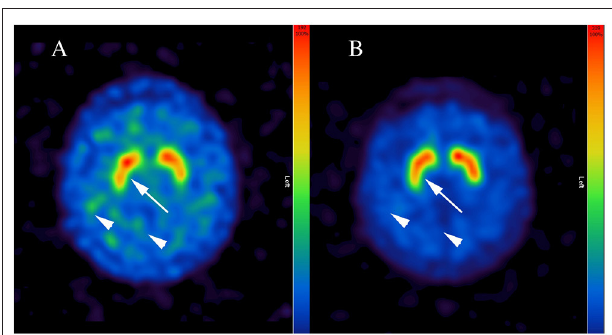
FIGURE 1 | Representative [ 123 I]FP-CIT-SPECT images of the patient. Note inhomogeneous and reduced dopamine transporter binding of the radiopharmaceutical in putamen bilaterally (arrow in A ) and low contrast between striatal and cortical binding during short-term bupropion therapy (arrowheads in A ), which normalized after a wash-out phase of four half-life periods (arrow and arrowheads in B ). Bupropion reduced the binding of [ 123 I]FP-CIT up to 45% (i.e., in right putamen).